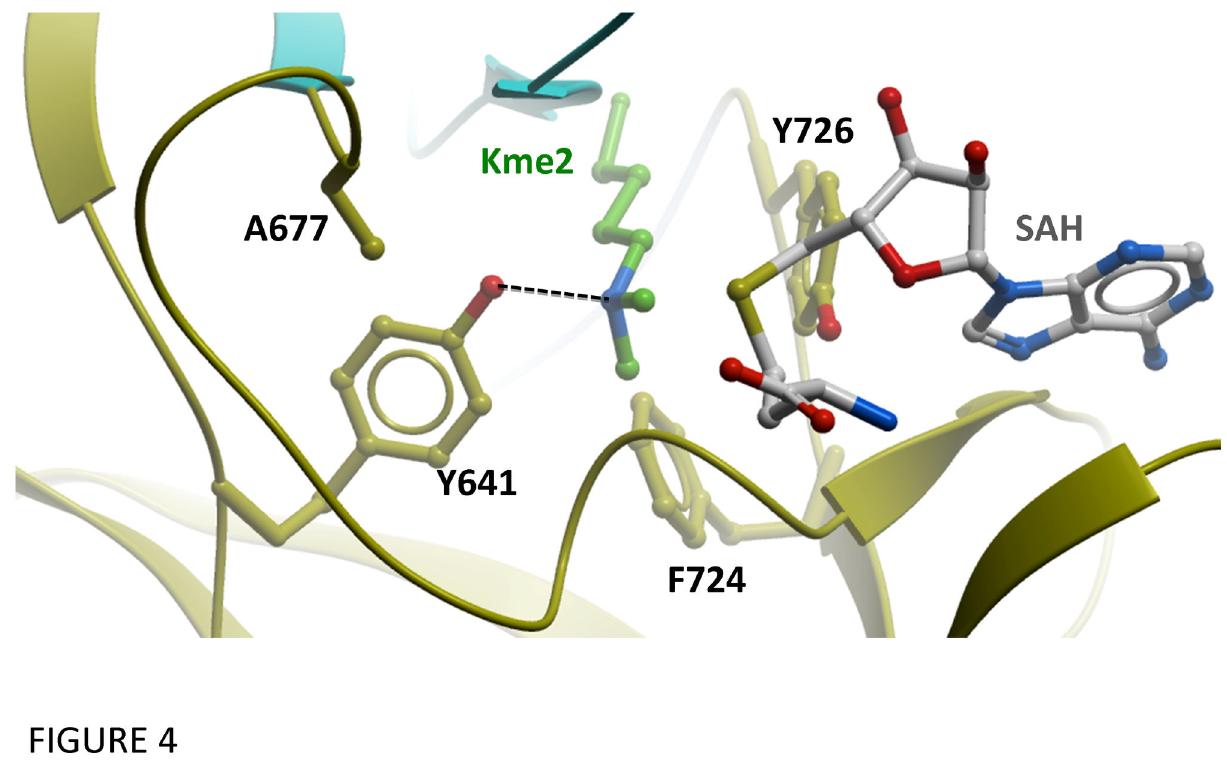
Figure 4. Structural basis for altered activity of mutations recurrent in lymphomas. Hydrogen bonding between Tyr 641 and the substrate lysine’s ε-nitrogen, and steric envelope of the tyrosine hydroxy group impose rotational constraints that penalize proper alignment with the cofactor’s scissile bond, required for displacement of a third methyl group. A677 stabilizes the conformation of Y641 hydrogen-bonded to the substrate lysine. The cofactor and substrate lysine are from a superimposed ternary structure of EHMT1/GLP